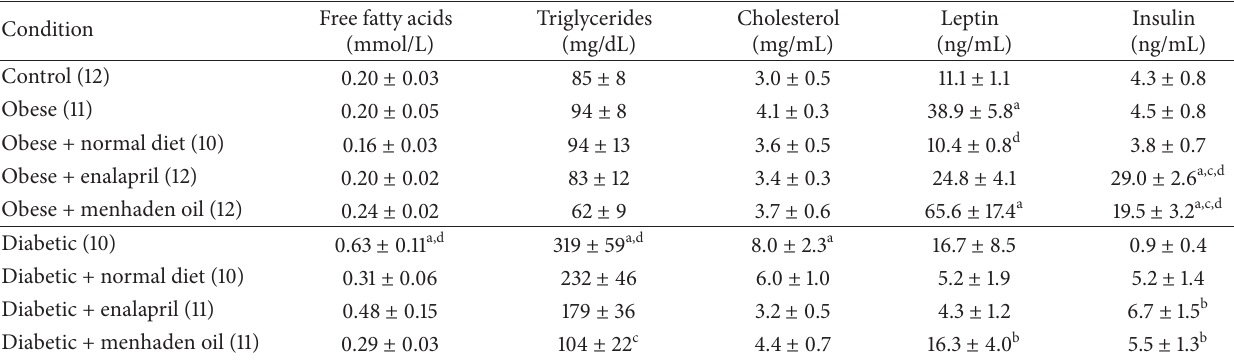
Table 2: Effect of reversal of high fat diet, enalapril, or menhaden oil in diet-induced obese or type 2 diabetic rats on nonfasting serum free fatty acids, triglycerides, cholesterol, leptin, and insulin levels. Condition